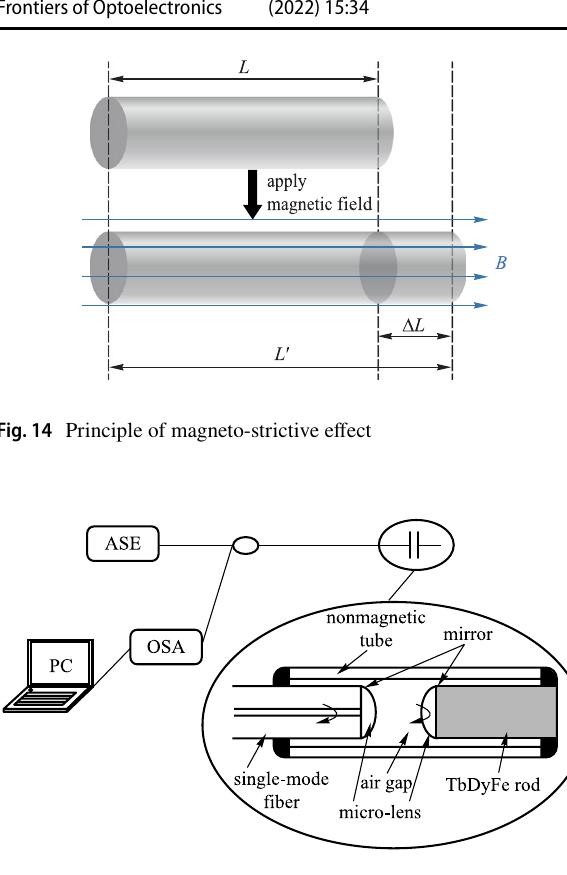
Fig. 15 Experimental setup of the high-finesse extrinsic Fabry–Perot interferometers (EFPI) based fiber-optic magnetic-field sensor [75]. Copyright 2015, Elsevier B.V. Reproduction with